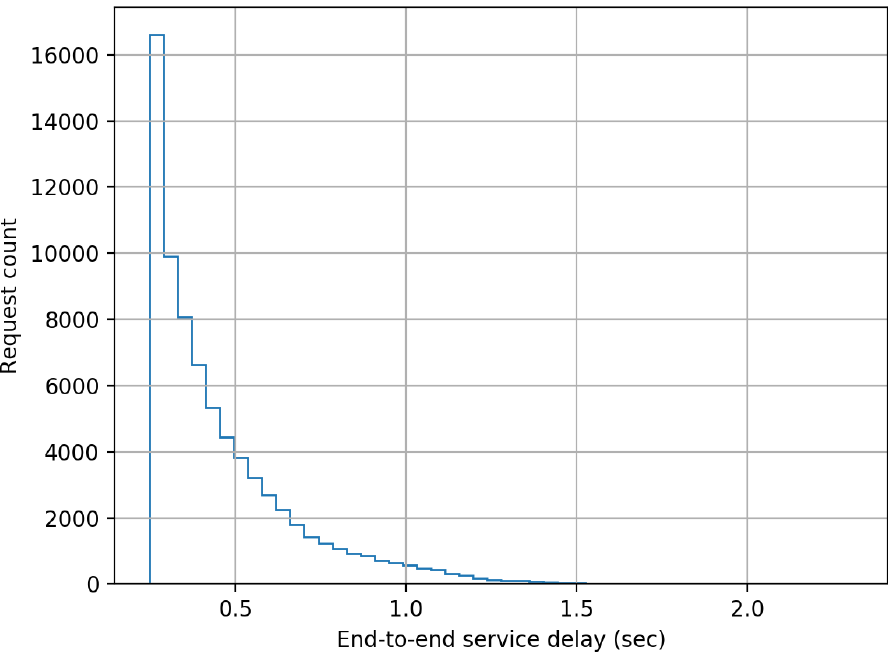
Figure 4. Distribution of end-to-end service delay at a mean request rate of 15